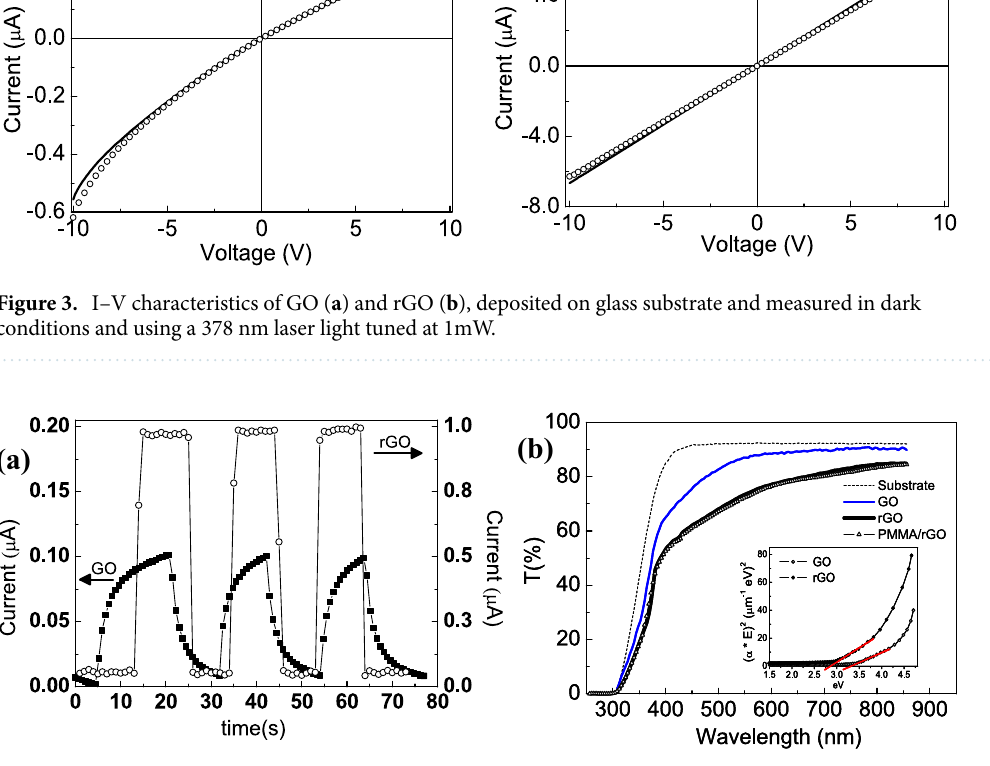
Figure 4. ( a ) Switching characteristics of GO and rGO samples irradiated with 378 nm at bias voltage of 5 V. In the graph three cycles in which the laser light is switched on and off are shown. ( b ) The percentage of optical transmittance of glass substrate, GO thin film, bare rGO and rGO covered by PMMA are compared. All the thin films are deposited on a glass substrate; (inset) Tauc’s plot analysis used to estimate the bandgap of GO and rGO. The red lines represent the fitting analysis used to obtain the band gap